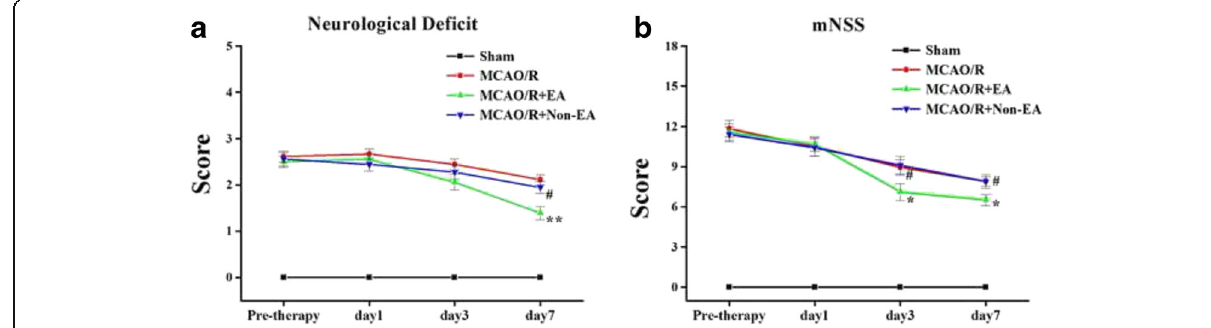
Fig. 1 Neurological functional outcome. a , b The Data of neurological deficit score and mNSS score are shown as mean ± S.E.M from 12 individual rats in each group. * P < 0.05, ** P < 0.01, the MCAO/R + EA group versus the MCAO/group; # P < 0.05, the MCAO/R+ Non-EA group versus the